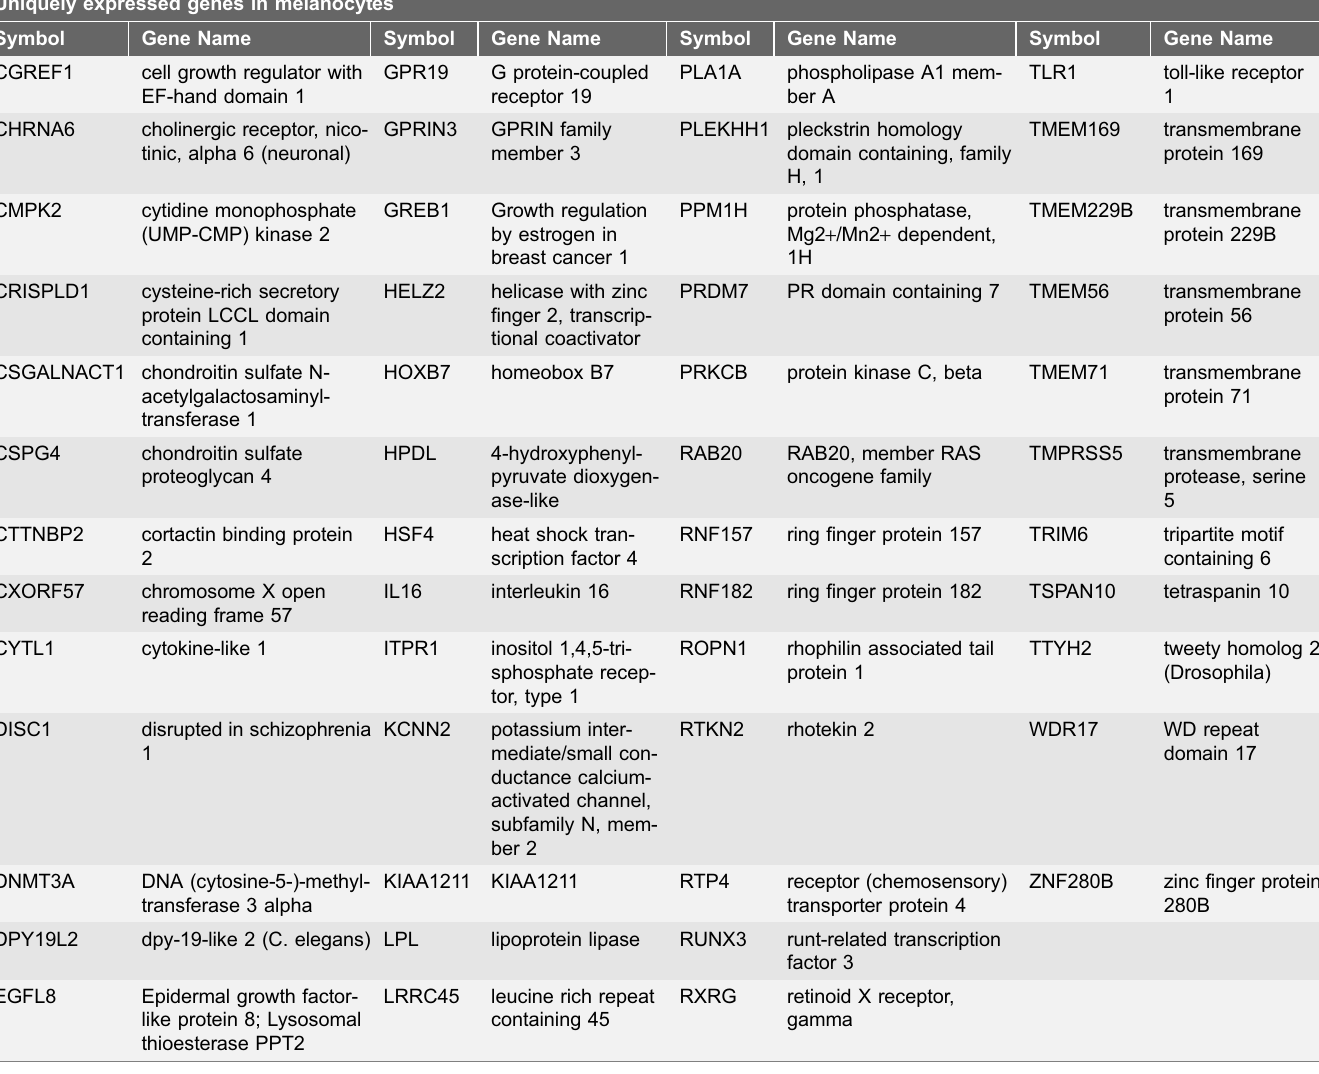
The list of genes, expressed in MC, but not in KC and